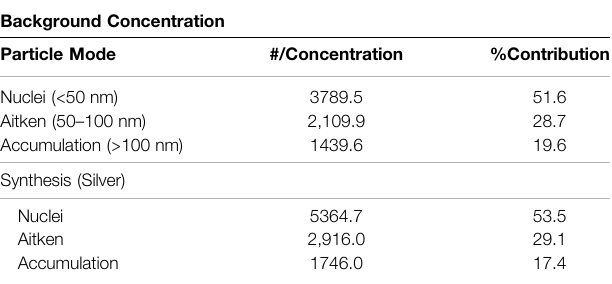
TABLE 5 | Particle number concentration and particle mode for the background and silver synthesis